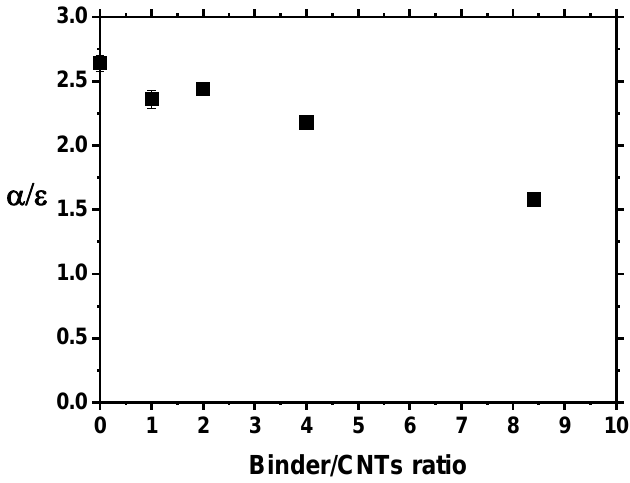
/ ε ) as a function of binder / CNT Figure 3. The selectivity (α/ε) as a function of binder/CNT ratio. Figure 3. The selectivity ( α